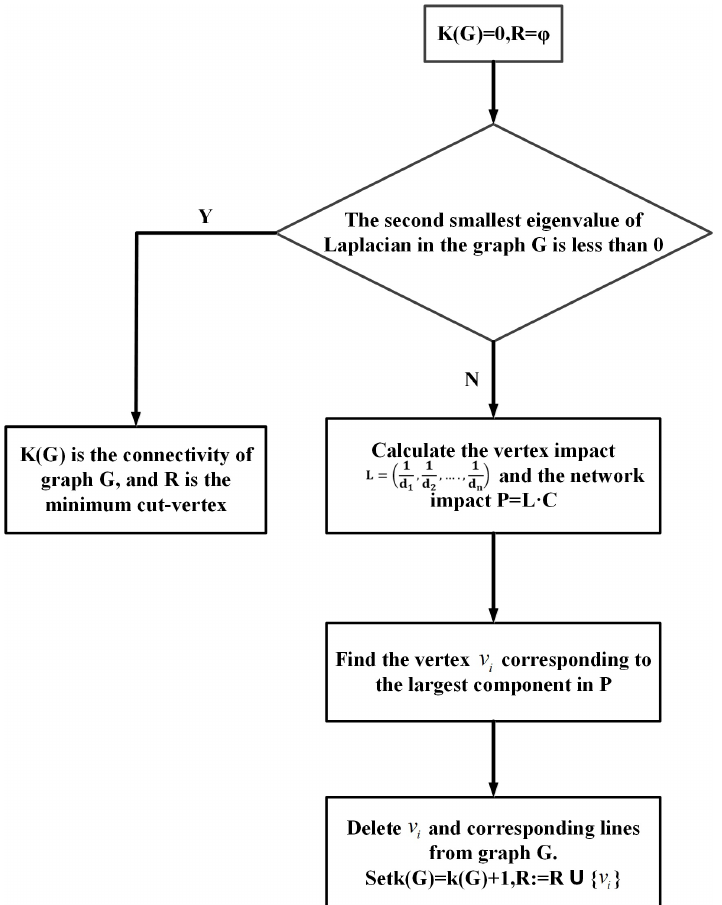
Figure 22. The algorithm flow chart of the undirected network